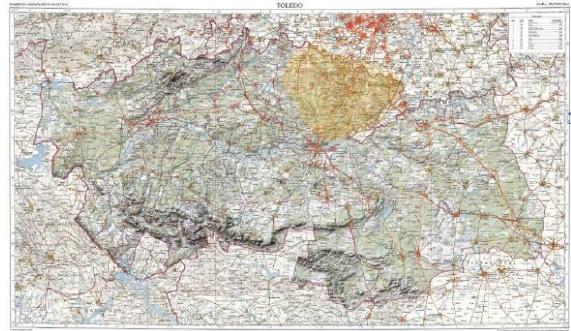
Figure 1. Location of La Sagra within the Toledo province (Base Plan: Instituto Geográfico Nacional,